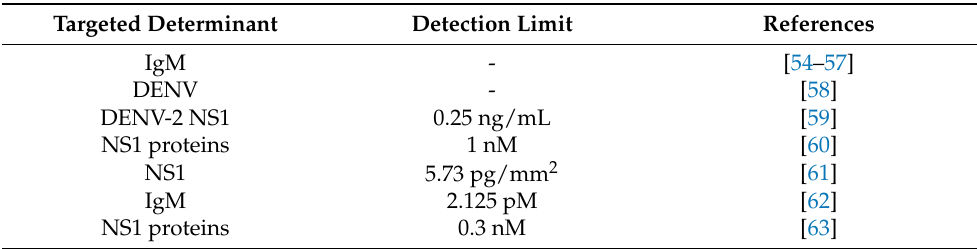
Table 1. Dengue virus (DENV) detection using surface plasmon resonance (SPR) sensor. Targeted